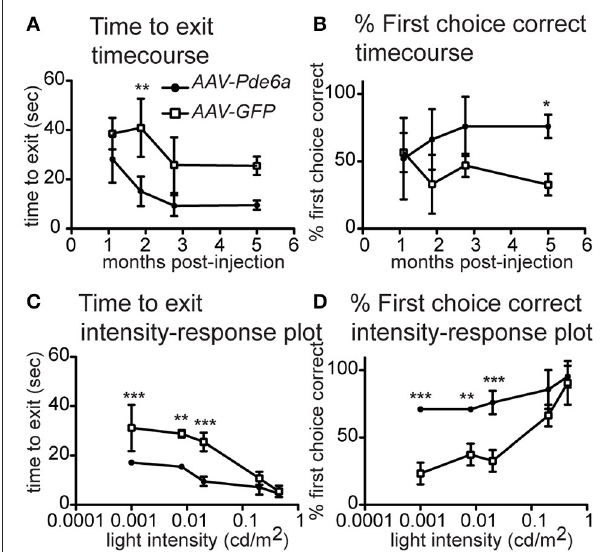
FIGURE 2 | Vision Testing. The visual navigation ability of a subset of treated dogs ( n = 3) was tested sequentially after injection ( AAV-Pde6a and contralateral AAV-GFP) . At mesopic lighting intensity (0.02 cd/m2), dogs tended to navigate more quickly using the AAV-Pde6a treated eye (A) , and make fewer incorrect choices (B) , although using a two-way repeated measures ANOVA, only select time-points were significantly different from control injected eyes. Consequently, even lower light intensities were tested at only the 5 month post-injection time-point. Following treatment, animals navigated significantly more quickly using AAV-Pde6a treated eyes (C) and made more correct exit choices than contralateral AAV-GFP treated eyes (D) at the three lowest light intensities tested (0.02, 0.008–0.01, 0.001–0.003 cd/m 2 ). (* p < 0.05, ** p < 0.01, *** p < 0.001, two way ANOVA using treatment and either time or light intensity as the two independent variables, Bonferroni